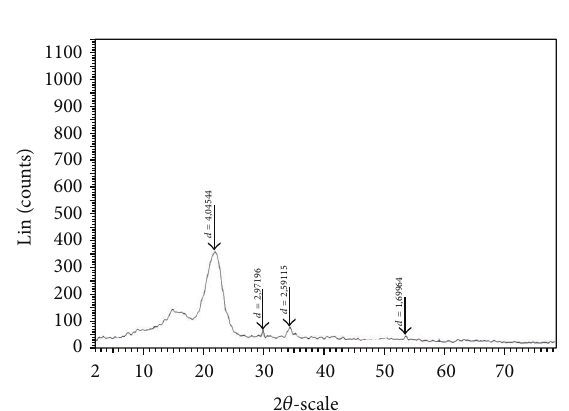
Figure 2: Powder XRD of